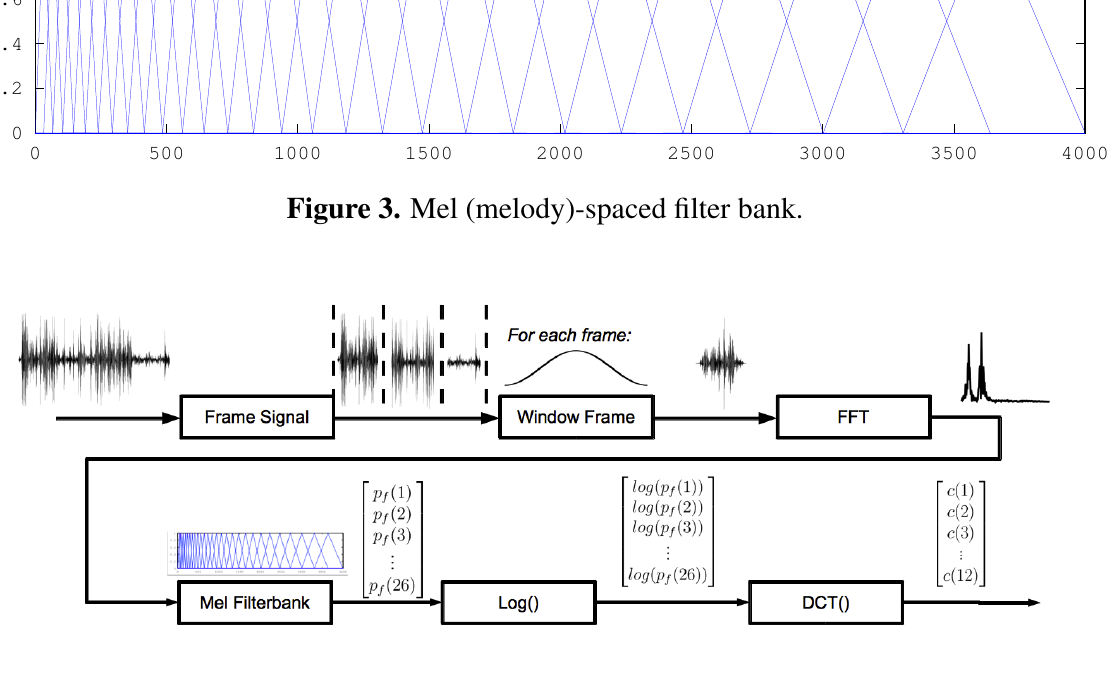
Figure 4. Mel frequency cepstrum coefficient (MFCC)